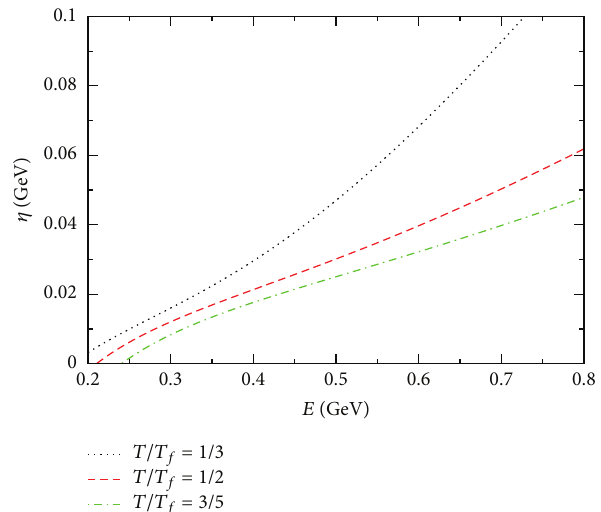
Figure 3: Energy dependence of the drag coefficient at 𝑇/𝑇 𝑓 = 1/3 (dotted curve), 𝑇/𝑇 𝑓 = 1/2 (dashed curve), and 𝑇/𝑇 𝑓 = 3/5 (dash dotted curve) [10].